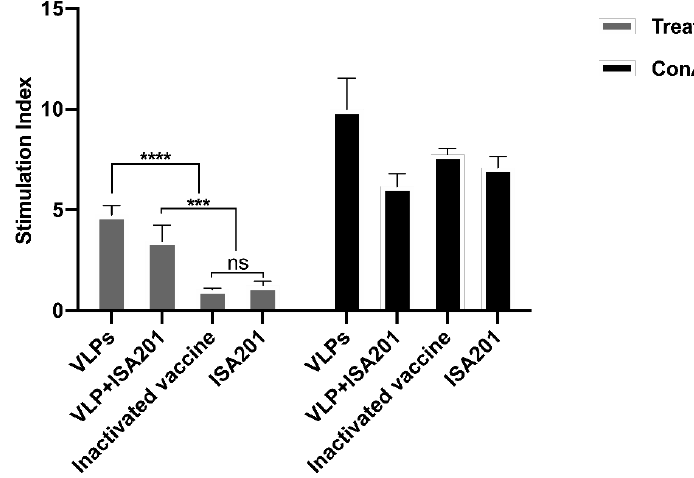
Figure 8. The effects of VLPs on splenocyte proliferation. Mice were immunized with 15 μg of VLPs with or without ISA201 adjuvant, a commercial BVDV-inactivated vaccine, or the ISA201 adjuvant alone. Splenocytes were collected on day 28 post-prime immunization and re-stimulated with the same antigen as those used for immunization, and cell proliferation was presented as mean of stimulation index (SI). Error bars are standard error of the mean. GP:0.1234 (ns), 0.0002 (***), <0.0001 (****).